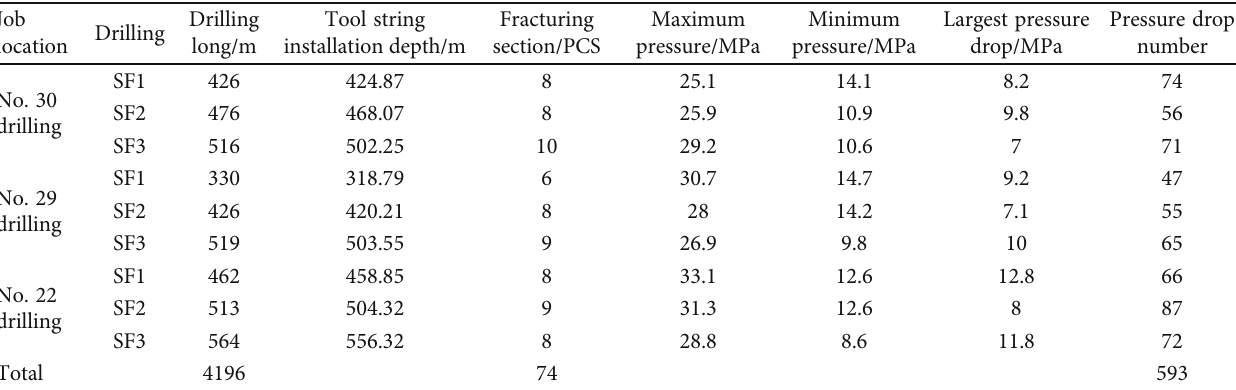
Table 2: Summary of fracturing drilling